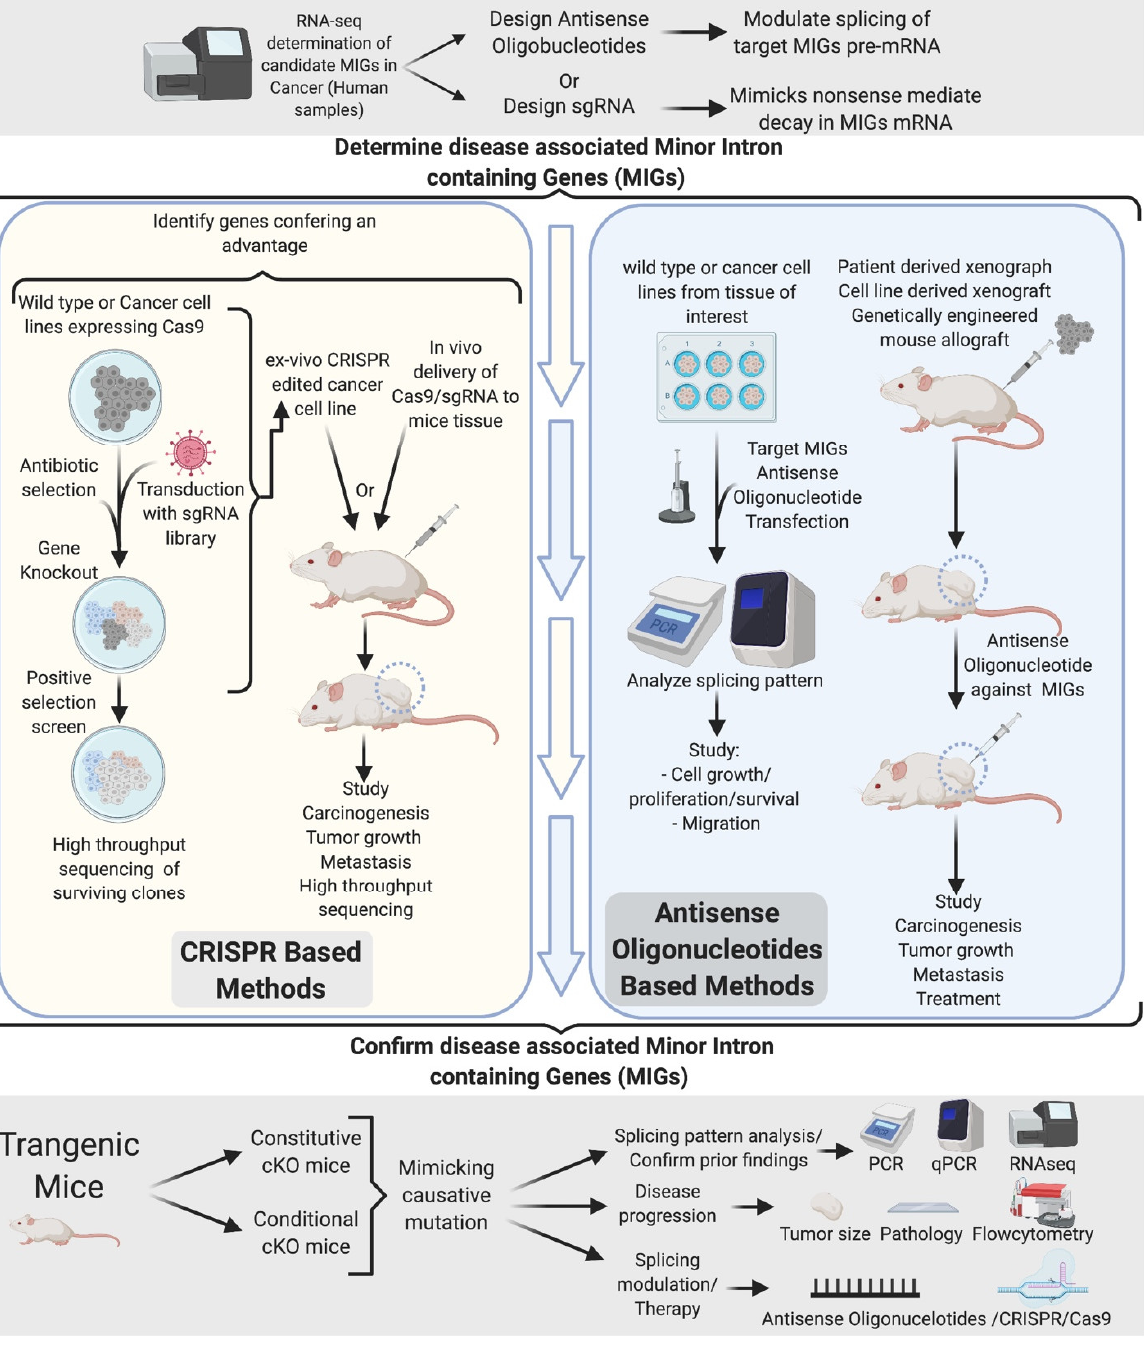
Figure 7. Experimental determination of disease-causing/-associated MIGs. Initial determination of disease-related MIGs through RNA-seq generates a list of potential candidates. Targeting of these candidates through CRISPR and ASOs in vivo and vitro narrows down the gene targets to a few. The ultimate confirmation comes from a genetically engineered mouse, mimicking the disease mutation found in human. This allows confirmation of mi-INTs splicing defects observed and determination of their contribution to the